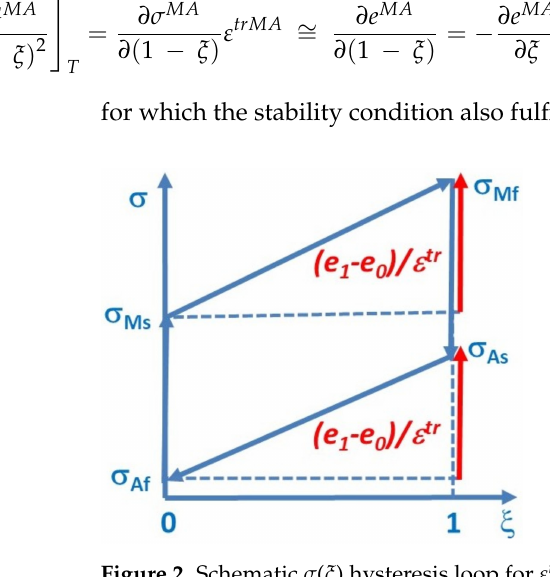
Figure 2. Schematic σ ( ξ ) hysteresis loop for ε tr = const. > 0. Since ε = ξε tr , with the actual value of ε , this plot corresponds to the σ versus ε